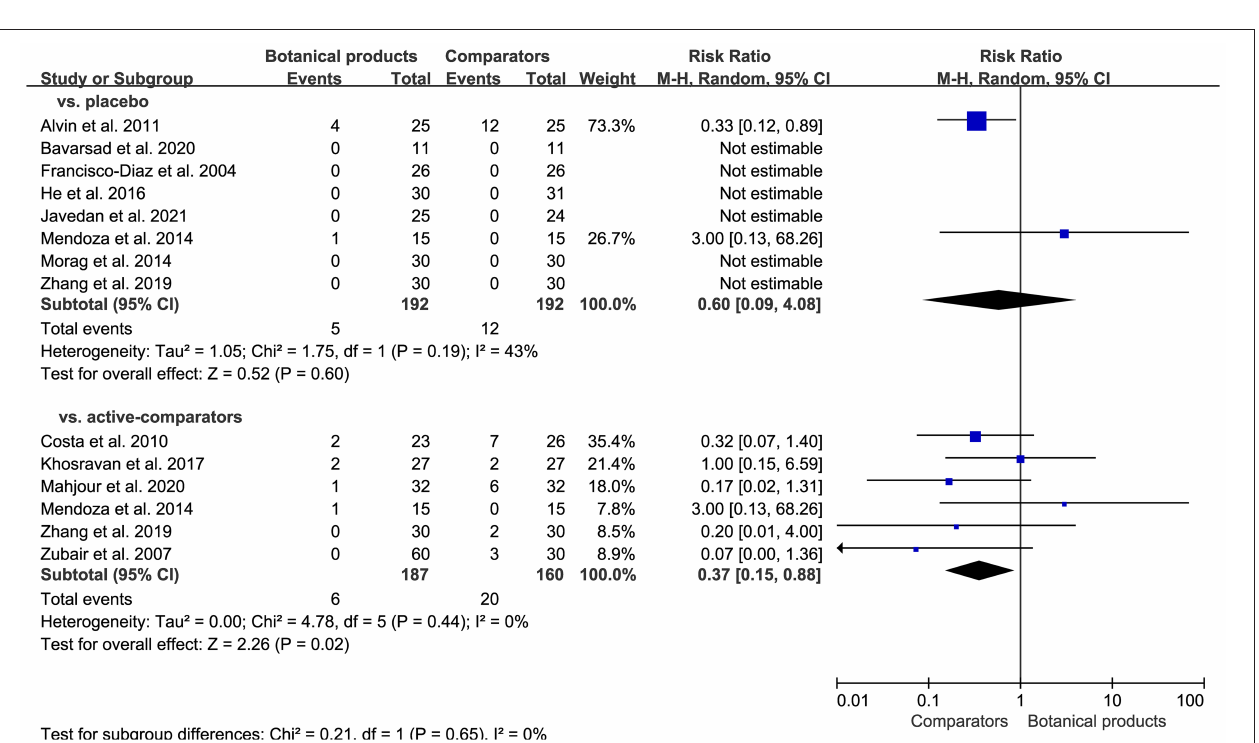
experiencing mild AEs. Our meta-analysis also suggested